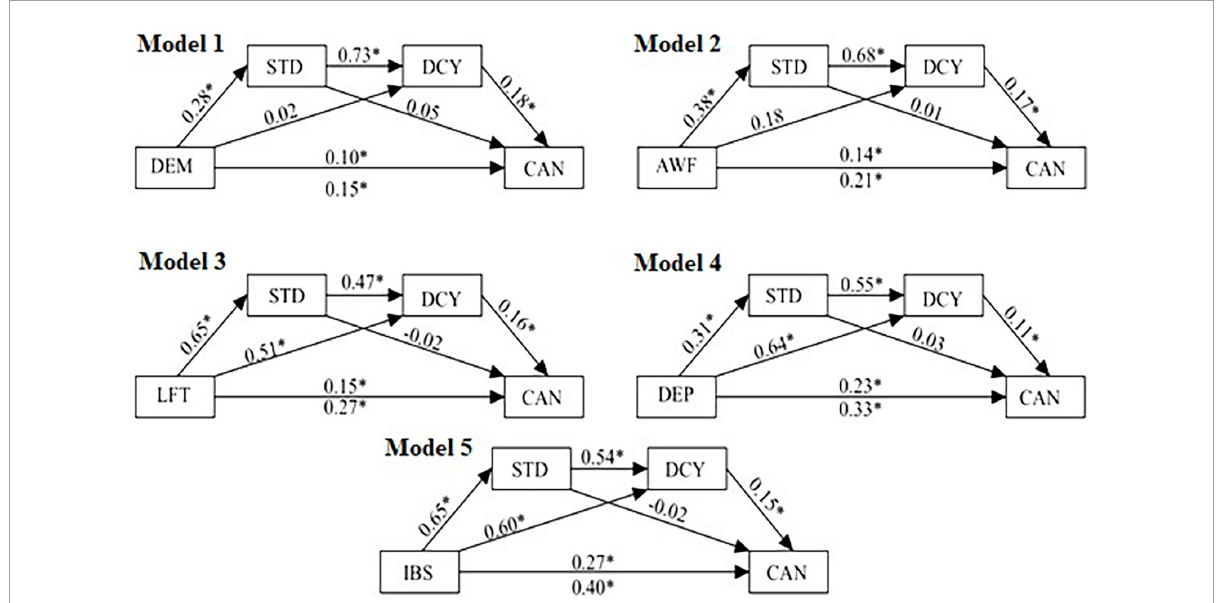
FIGURE2 Regression weights for the SAMM models with irrational beliefs (iPBI; DEM, AWF, LFT, DEP, IBS), perfectionism (SAPS; STD, DCY) and cognitive anxiety (CSAI-2; CAN). ∗ p < 0.05. DEM, demandingness; LIT, low-frustration tolerance; AWF, awfulizing; DEP, depreciation; IBS, total of irrational beliefs; STD, standards (adaptive perfectionism); DCY, discrepancy (maladaptive perfectionism); CAN, cognitive